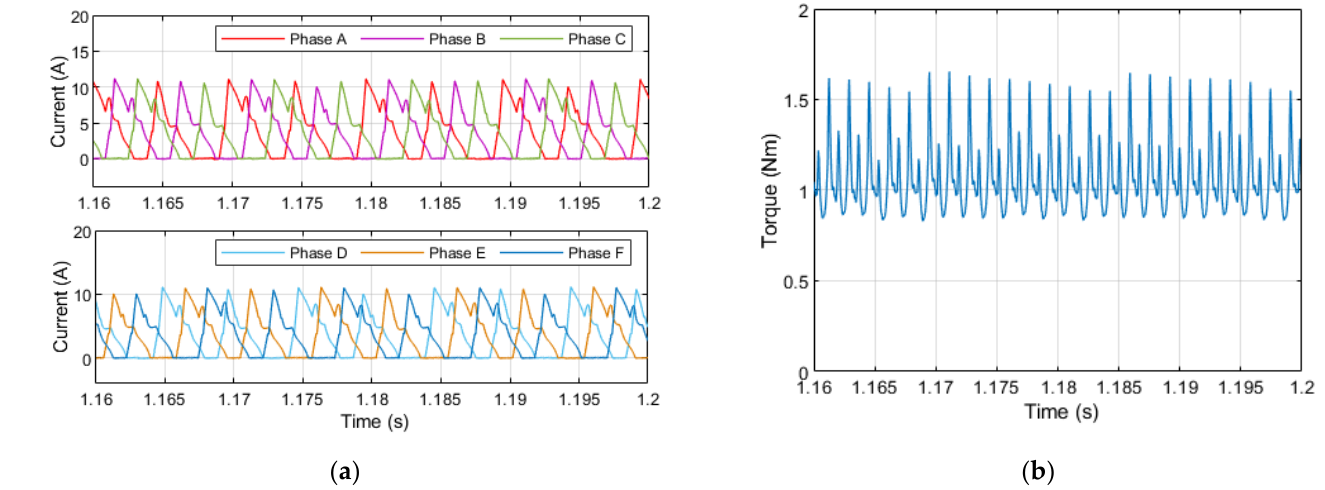
Figure 17. MATLAB/Simulink simulation results at 3000 rpm: ( a ) current waveforms. ( top ) Phase A, B and C, ( bottom ) Phase D, E and F; ( b ) torque waveform.